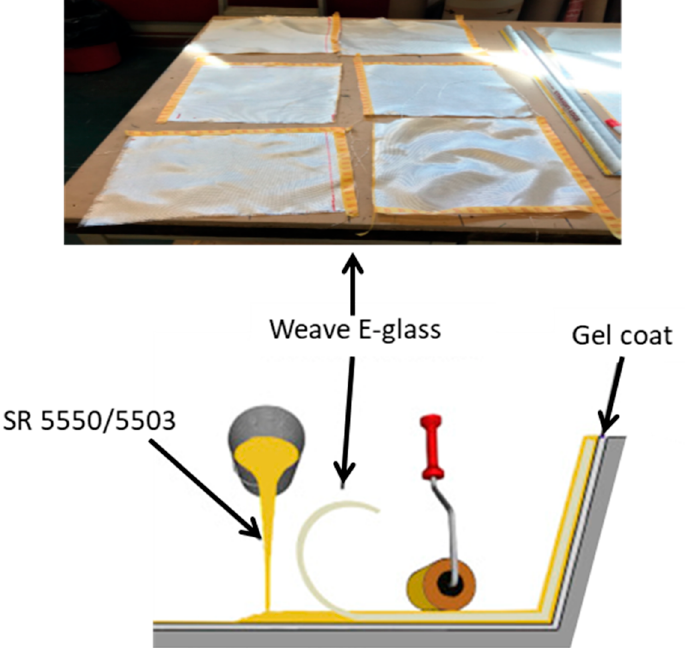
Figure 2. Schematic of the fabrication process and image of the weave E-glass fiber textiles used for the fabrication of the composite panel.